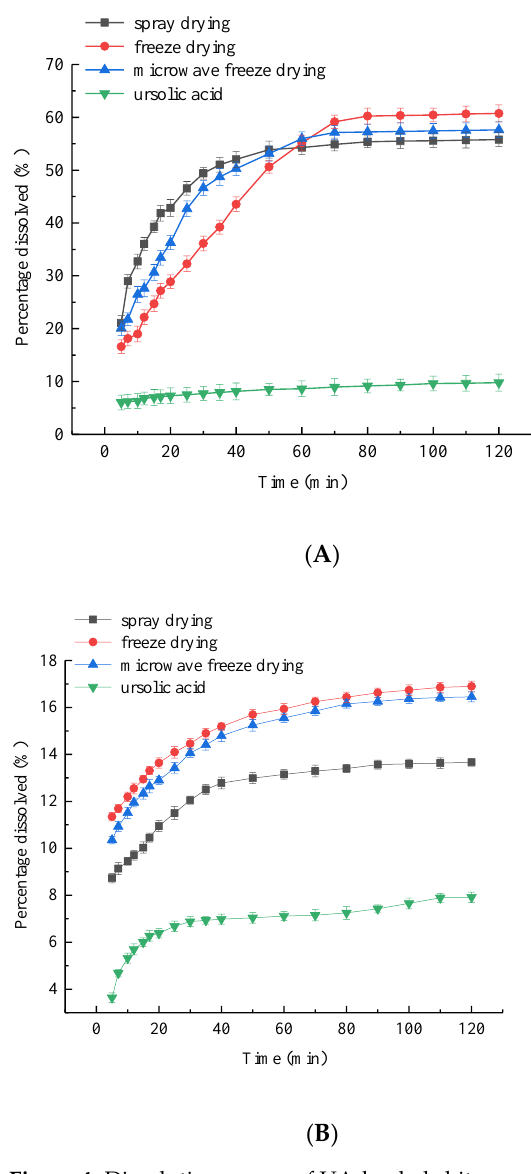
Figure 4. Dissolution curves of UA-loaded chitosan nanoparticles prepared by different methods in SGF ( A ) and SIF ( B ).